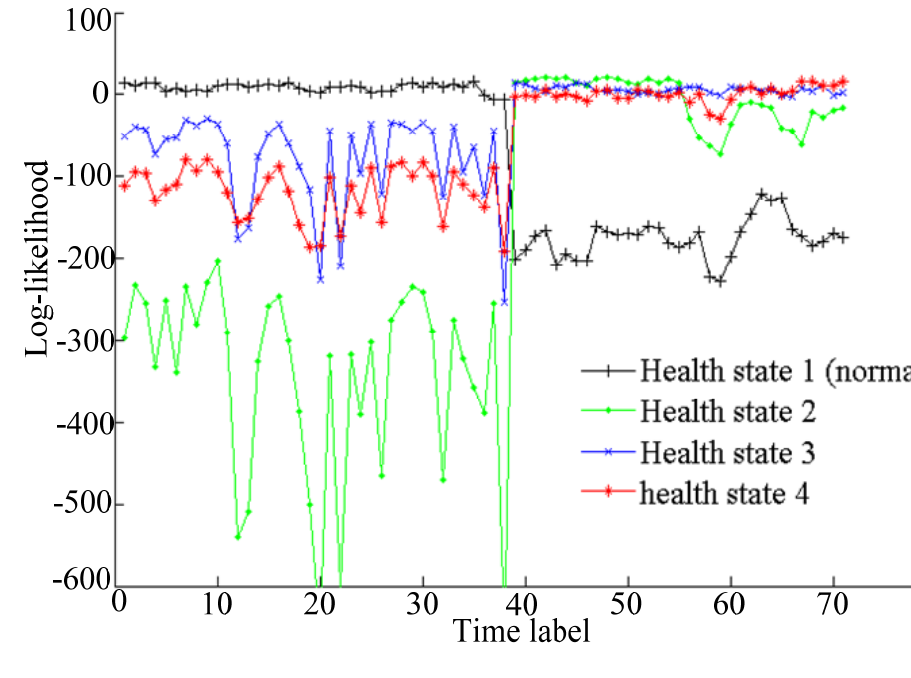
Figure 11. Log-likelihoods for the four state HMMs of the test life time data.